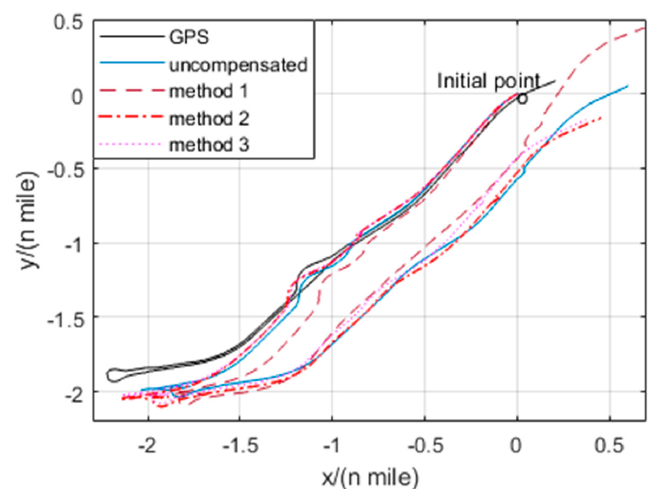
Figure 15. Trajectories of the navigation experiment.